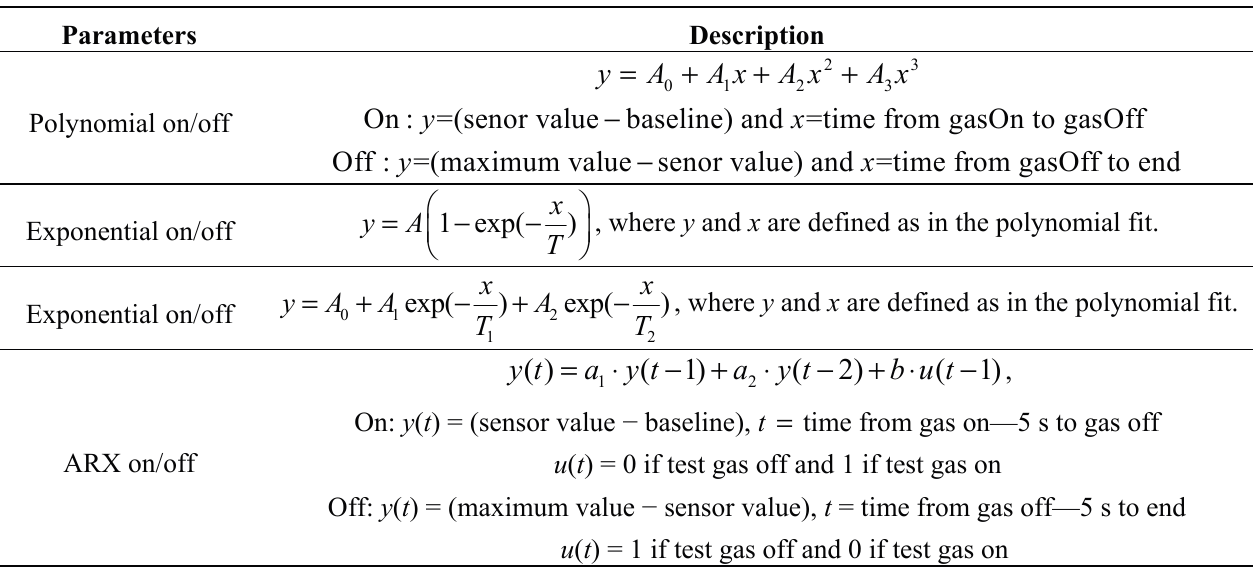
Table 6. Description of features extracted from curve fitting models in [52]. Parameters